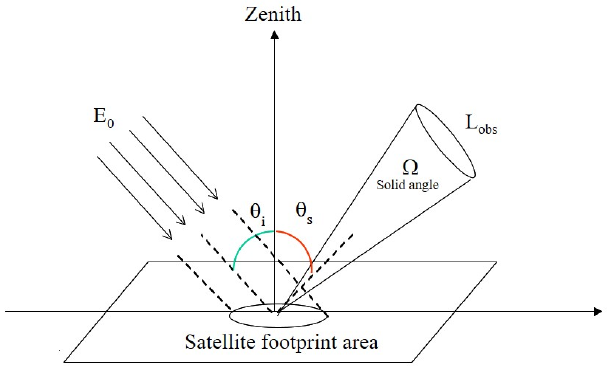
Figure 2. General concept of a satellite- or ground-based remote sensing measurement of reflected radiance. θ i is the incidence angle of incoming irradiance and θ s is the instrument’s viewing angle. The incoming Sun irradiance E 0 is projected to the Earth’s surface (in- strument’s footprint area) with the magnitude E 0 cos( θ i ). The instru- ment measures the reflected radiance L obs within its viewing angle (i.e. the radiant flux per unit solid angle, (cid:127) solid angle ). The ratio be- tween the reflected and incoming radiation provides reflectance ac- cording to Eq. (2). The azimuth angle is omitted for simplicity. The figure is adapted from Salminen